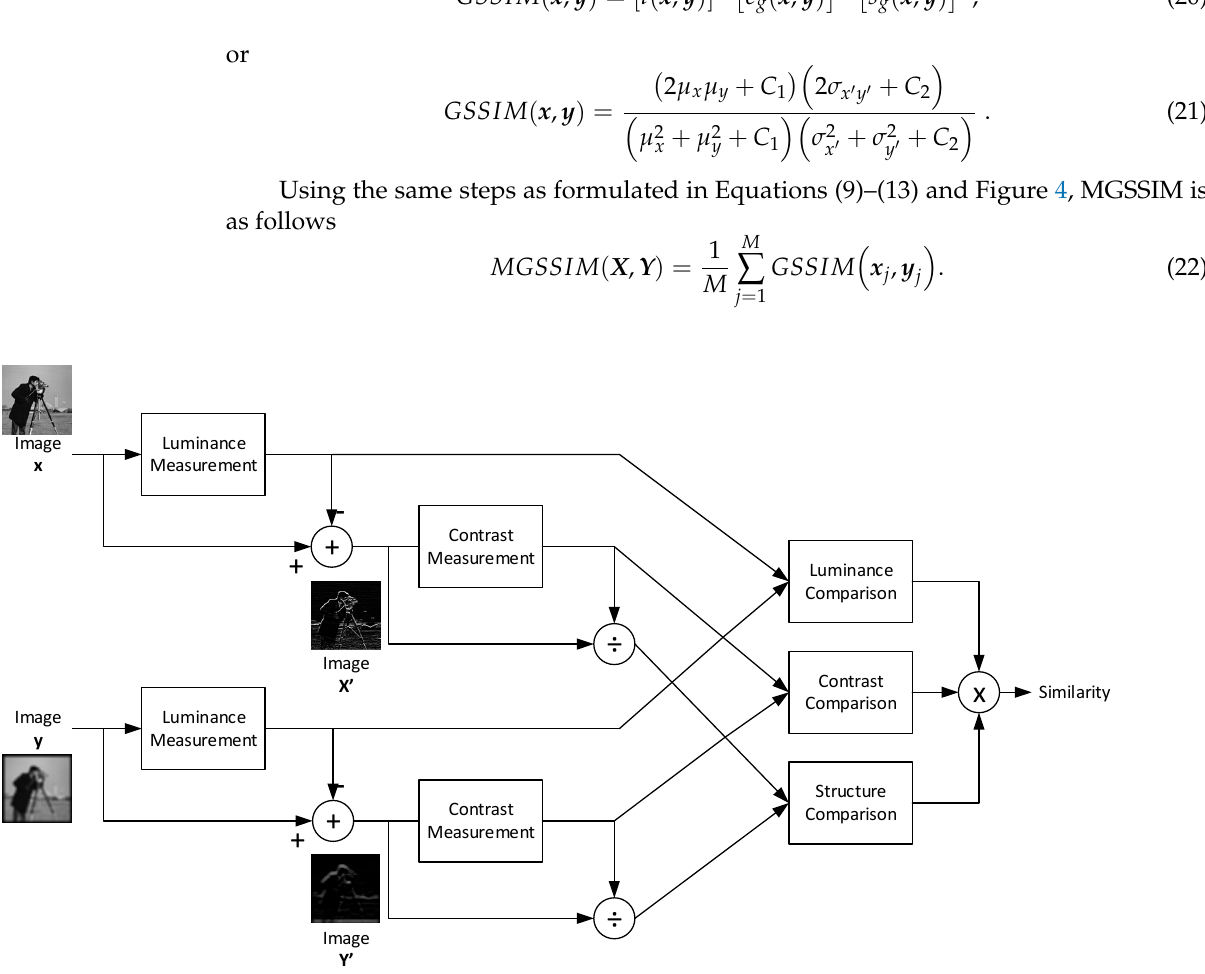
Figure 4 . GSSIM procedures to quantify the image quality. Figure 4. GSSIM procedures to quantify the image